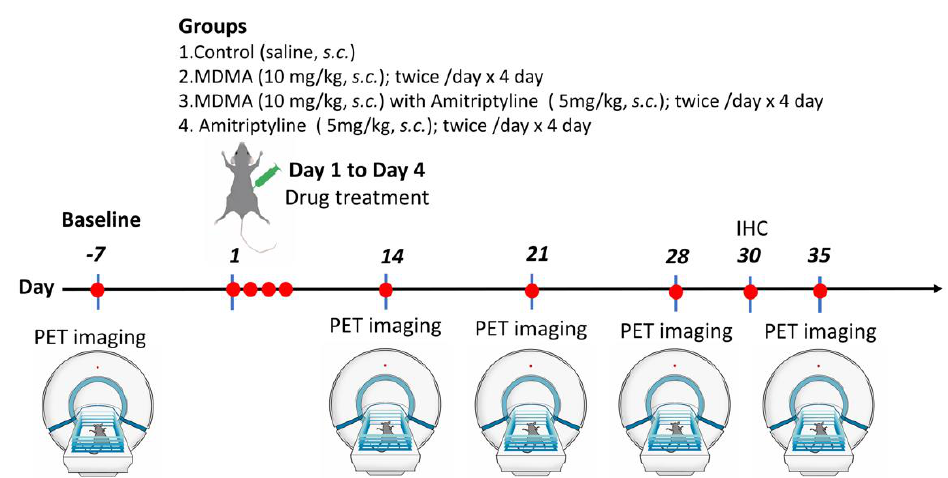
Figure 7. Schematic and graphical representation of the study design. A total of 24 rats underwent 4-[ 18 F]-ADAM PET imaging at baseline (pre-drug). One week later, animals were randomly grouped into 4: Group 1 as a control, Group 2 MDMA alone, Group 3 AMI with MDMA, Group 4 AMI alone. Rats received drug treatment twice daily on days 1, 2, 3, 4. Then, 4-[ 18 F]-ADAM micro-PET imaging was performed on days 14, 21, 28, and 35. Immunohistochemistry was performed on day 30 ( n = 3/group, Supplementary Materials) and the rest of animals were used for the end point imaging on day 35.